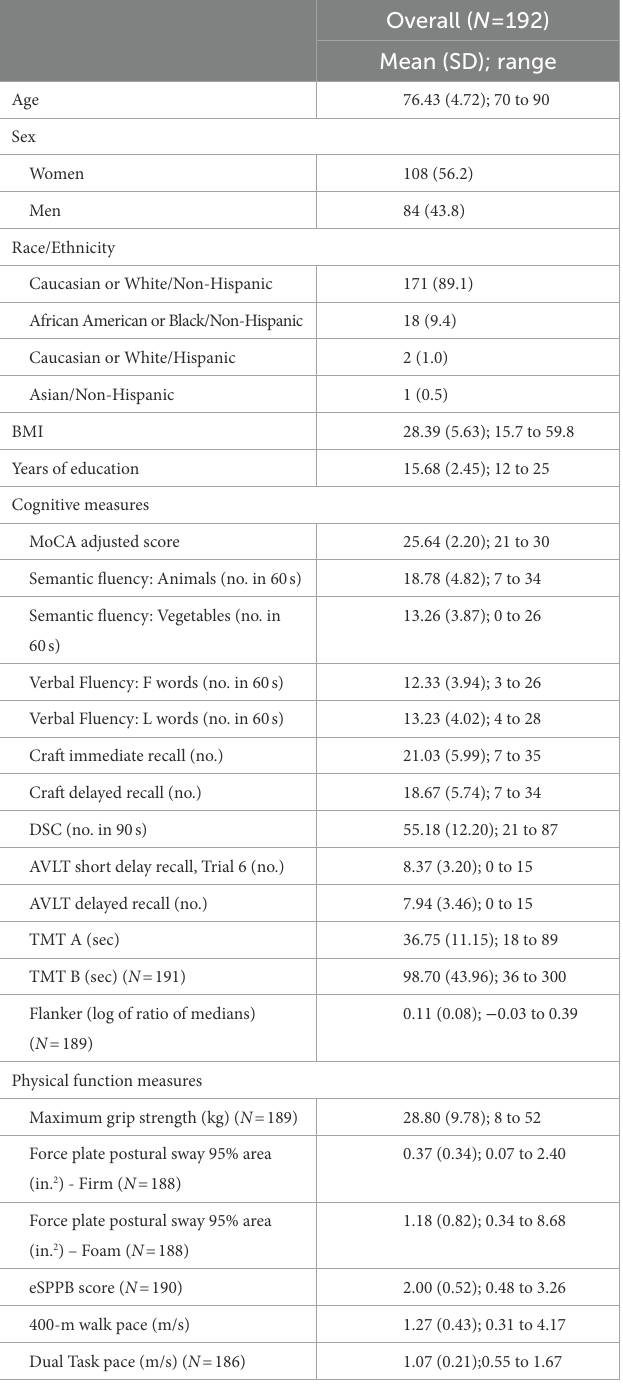
TABLE 1 Descriptive statistics from participants at baseline in the BNET